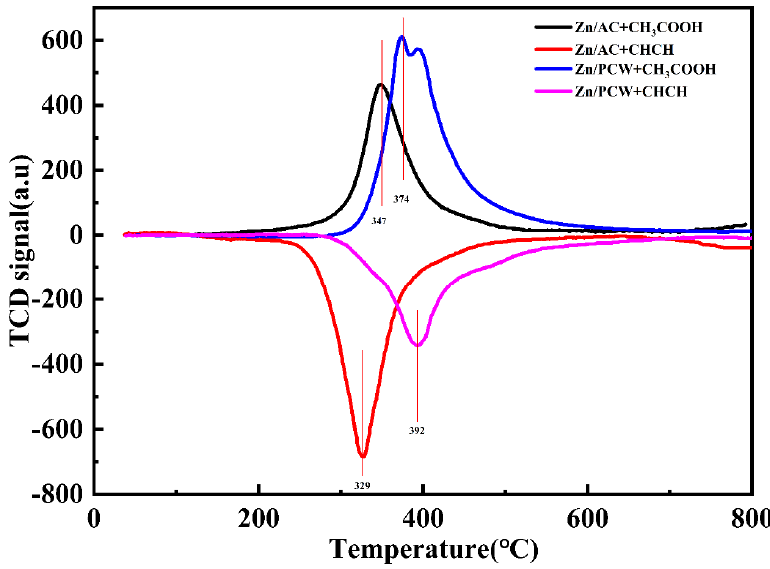
Figure 6. TPD results of Zn/AC and Zn/PCW with CH 3 COOH and C 2 H 2 . TCD = Thermal conduc- tivity detector.